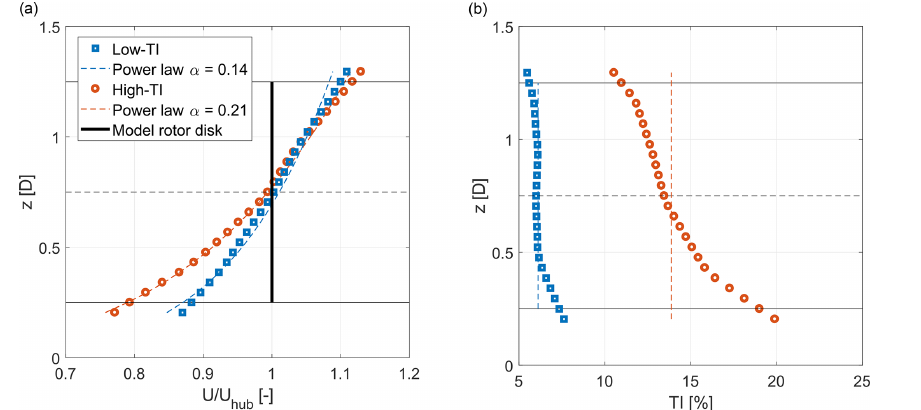
Figure 3. Vertical wind speed profile (a) and turbulence intensity (b) as a function of height above the tunnel floor, for low (low-TI) and high (high-TI) turbulence experiments.